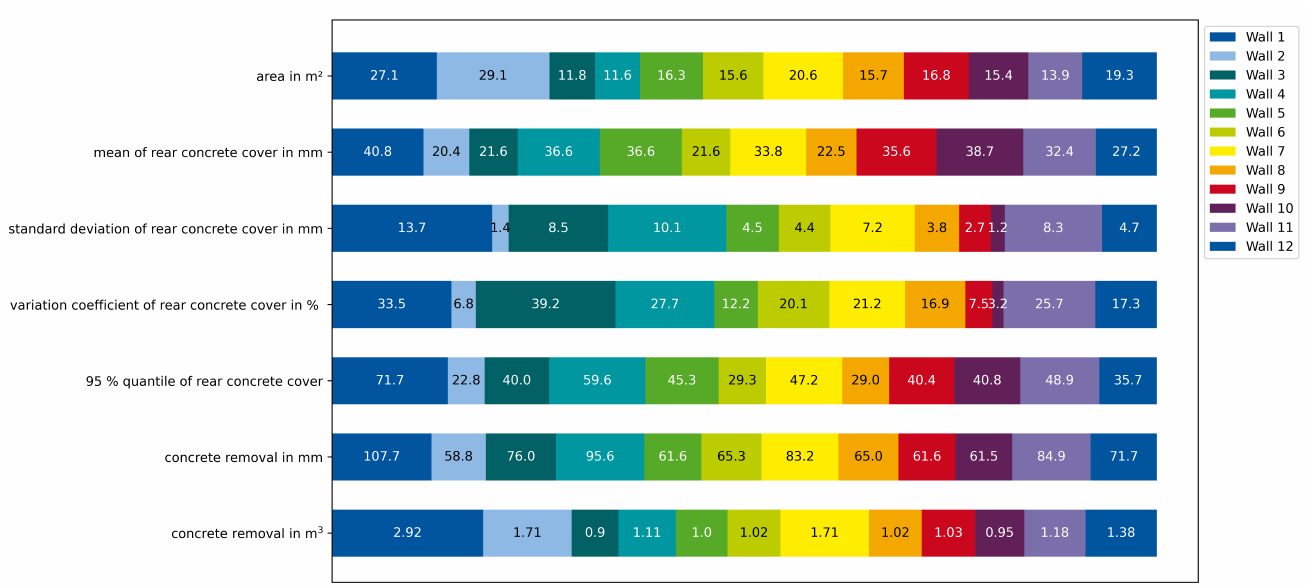
Figure 9. Statistics of concrete cover (rear reinforcement layer) and required concrete removal for method 7.2 separated for each